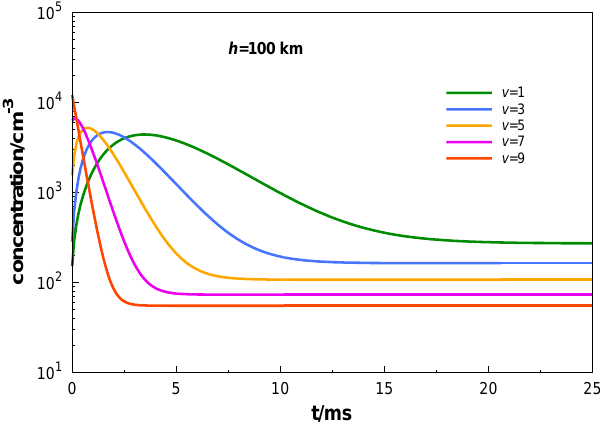
Fig. 7. Variation with time of the concentration of the various OH ( v ) species as integrated numerically using the QCT results from Varandas (2004a)